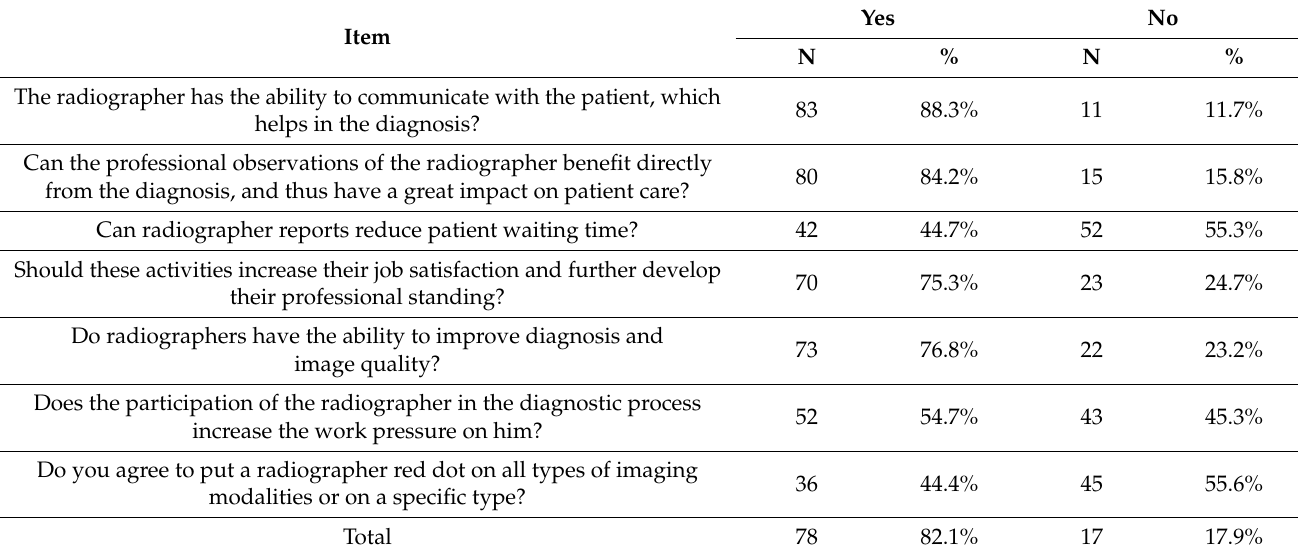
Table 2. Frequencies and percentages of radiologists and radiographers toward the role of the radiographers in radiological reports (n = 95).